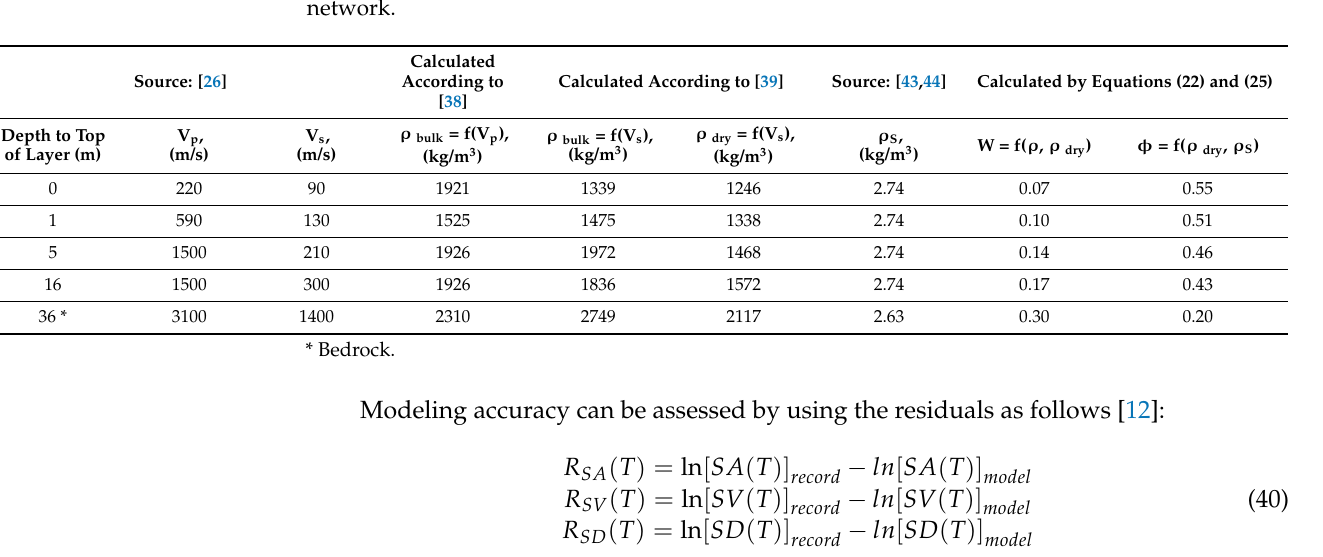
Figure 9. Comparison of response spectra (damping 5%) of modeled and recorded accelerograms (components EW, NS, UD; spectral acceleration—SA, spectral velocity—SV, spectral displace- ment—SD) calculated for the surface of soil layers at Kik-net site TCGH15.